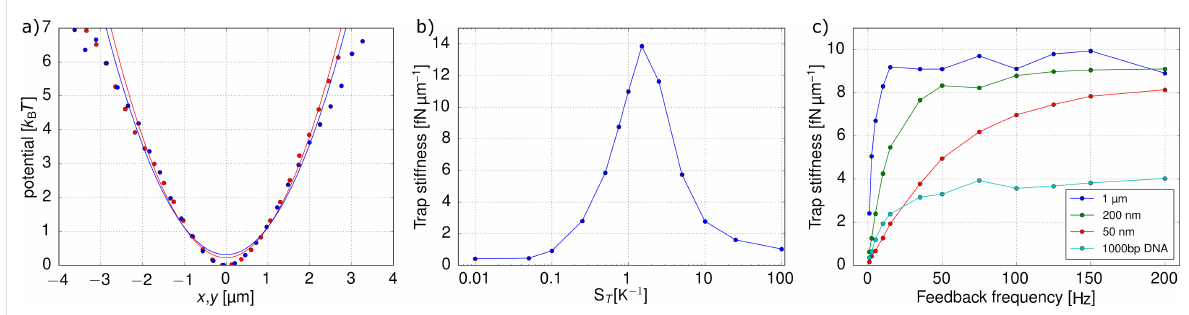
Figure 3: Simulation results: (a) Trapping potential in x - and y -directions, calculated from the simulated motion of a 200 nm bead. The simulation pa- rameters are equal to the experimental conditions of Figure 2. (b) Trap stiffness at a constant feedback frequency of 35 Hz as a function of the Soret coefficient for a 200 nm bead. (c) Trap stiffness as a function of the feedback loop frequency for different particles: beads with a diameter of 1000, 200, and 50 nm (all with the same S T ) and a 1000 base pairs long DNA